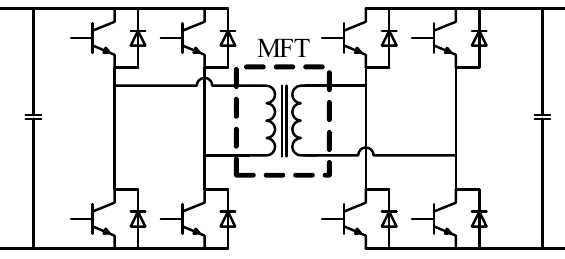
Figure 1. The topology of dc-dc converter.